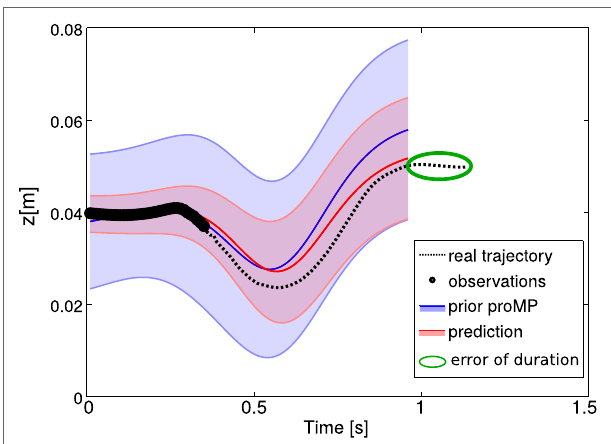
FIGURE 4 | This plot shows the predicted trajectory given early observations (data points, in black), compared to the ground truth (e.g., the trajectory that the human intends to execute with the robot). We show the prior distribution (in light blue) and the posterior distribution (in red), which is computed by conditioning the distribution to match the observations. Here, the posterior simply uses the average (cid:11) computed over the (cid:11) 1 ,…, (cid:11) K of the K demonstrations. Without predicting the time modulation from the observations and using the average (cid:11) , the predicted trajectory has a duration that is visibly different from the ground